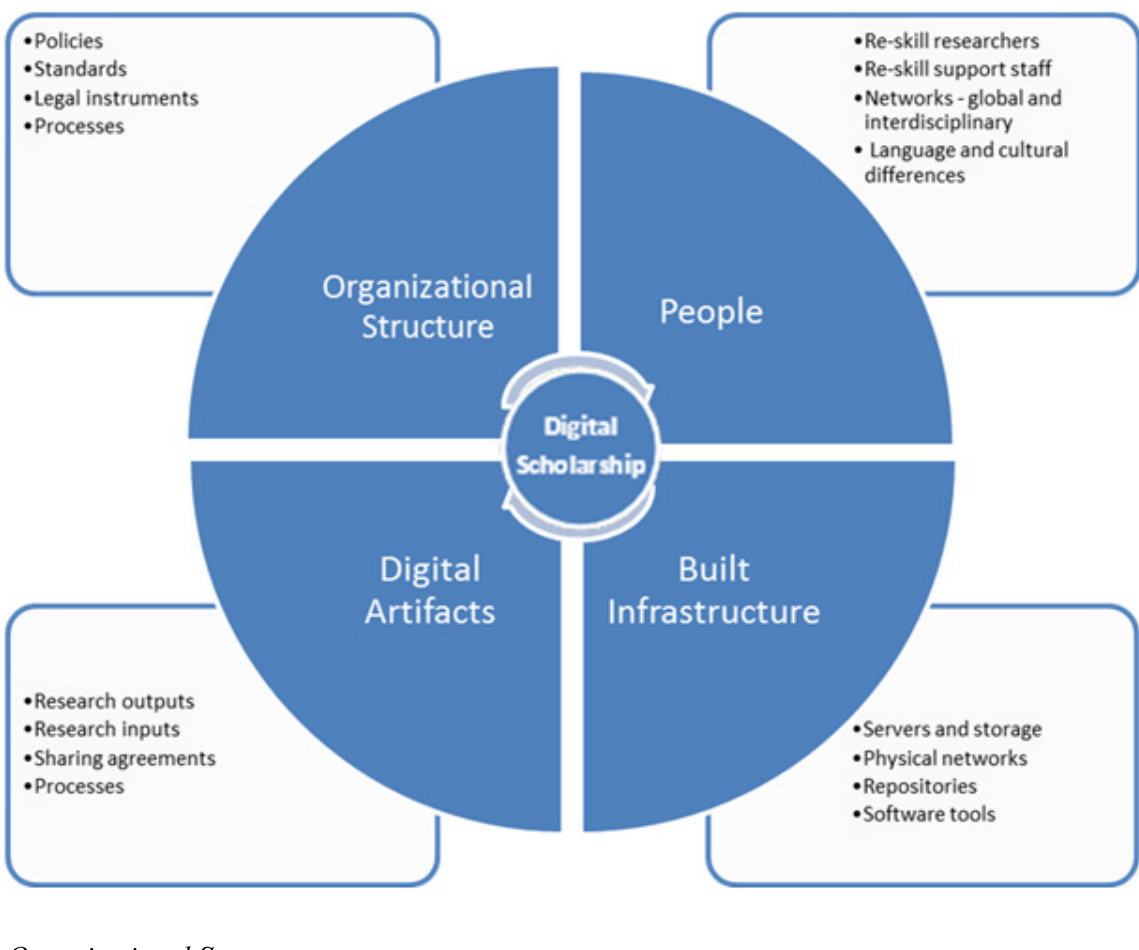
Figure 1. Institutional Infrastructure